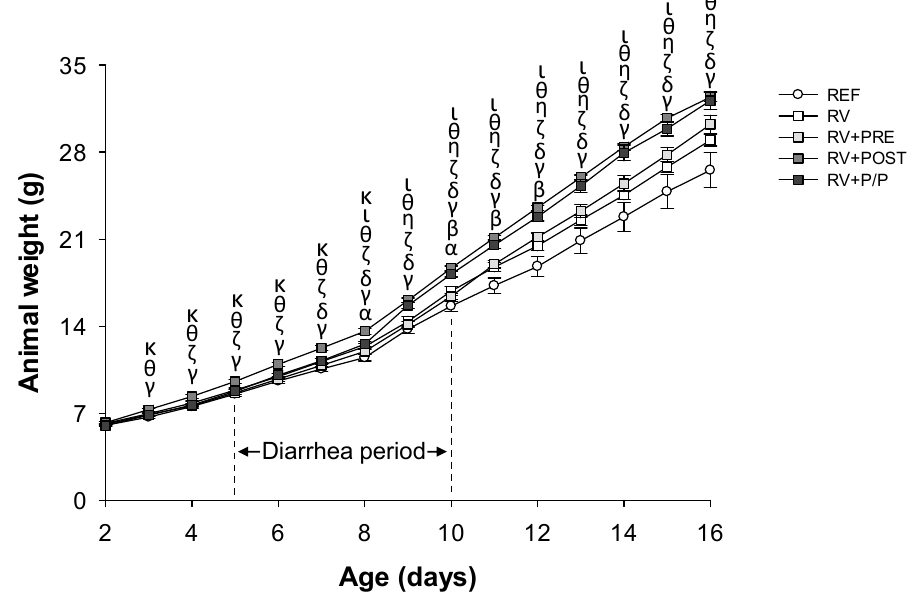
Figure 1. Body weight (g) during the study (day 2 to day 16 of life). Results are expressed as mean ± SEM ( n = 24 animals/group). Statistical differences: α p < 0.05 RV vs. REF, β RV + PRE vs. REF, γ RV + POST vs. REF, δ RV + P/P vs. REF, ζ RV + POST vs. RV, η RV + P/P vs. RV, θ RV + POST vs. RV + PRE, ι RV + P/P vs. RV + PRE, and κ RV + P/P vs. RV + POST. REF: reference group; RV: rotavirus group; RV + PRE: rotavirus group supplemented with a mixture of scGOS/lcFOS; RV + POST: rotavirus group supplemented with Lactofidus TM ; RV + P/P: rotavirus group supplemented with the combination of both.